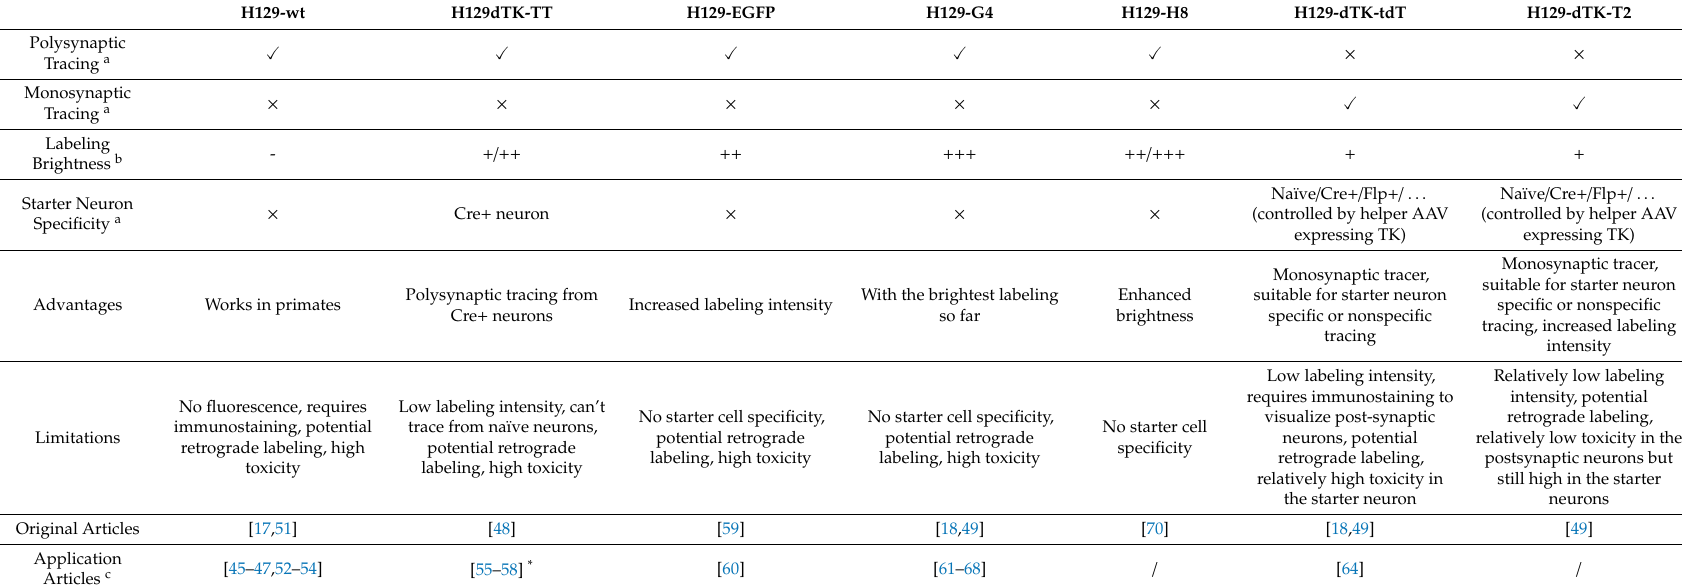
Table 1. Current H129-derived anterograde transneuronal tracers and their